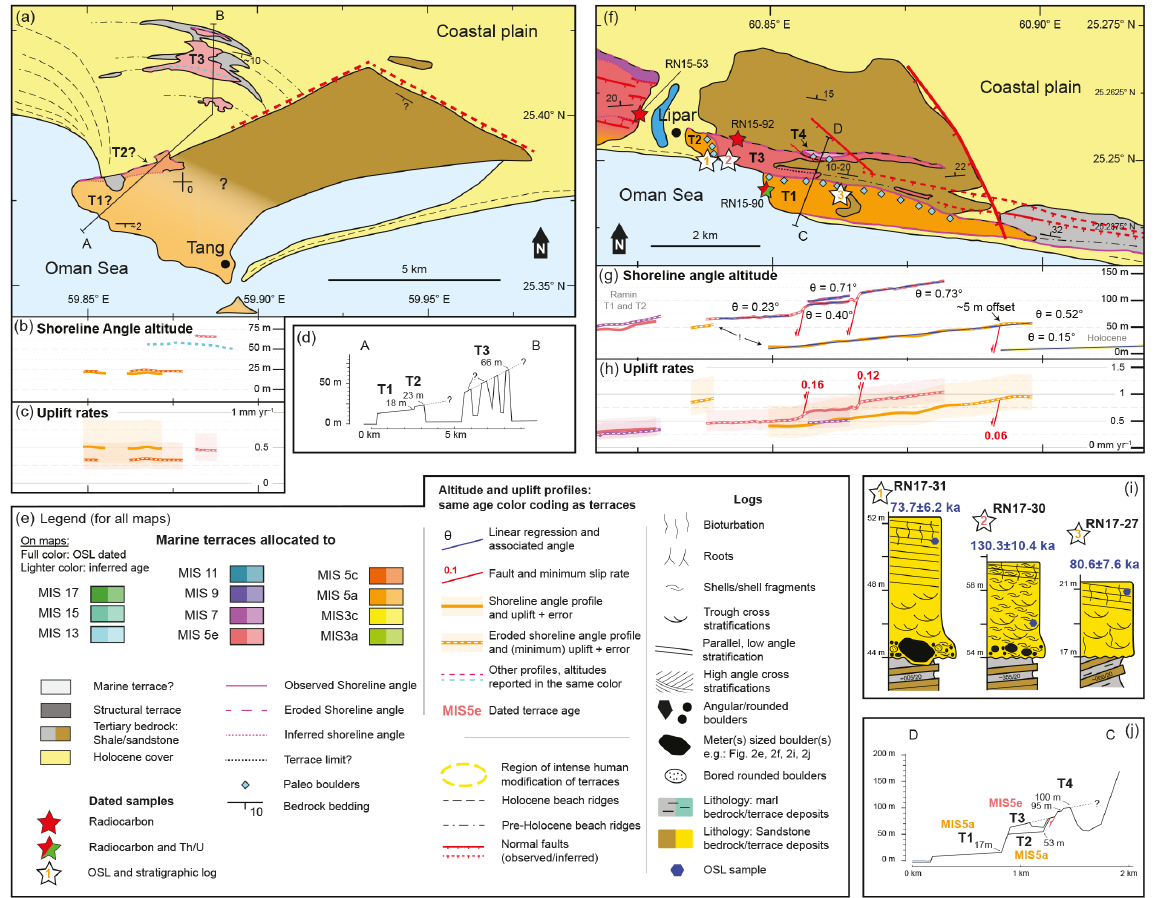
Figure 4. Terrace maps of the Tang and Lipar regions (see Fig. 1). (a) Terrace map of Tang. (b) Shoreline angle altitude in an east– west profile. (c) Uplift rates. (d) Altitude profile through the terraces (profile A–B). (e) Legend for all terrace maps, sedimentary logs and altitude/uplift profiles. (f) Terrace map. (g) Shoreline angle altitude in an east–west profile. (h) Uplift rates. (i) Sedimentary log at sampling locations and sample OSL age (blue). (j) Altitude profile through the terraces (profile